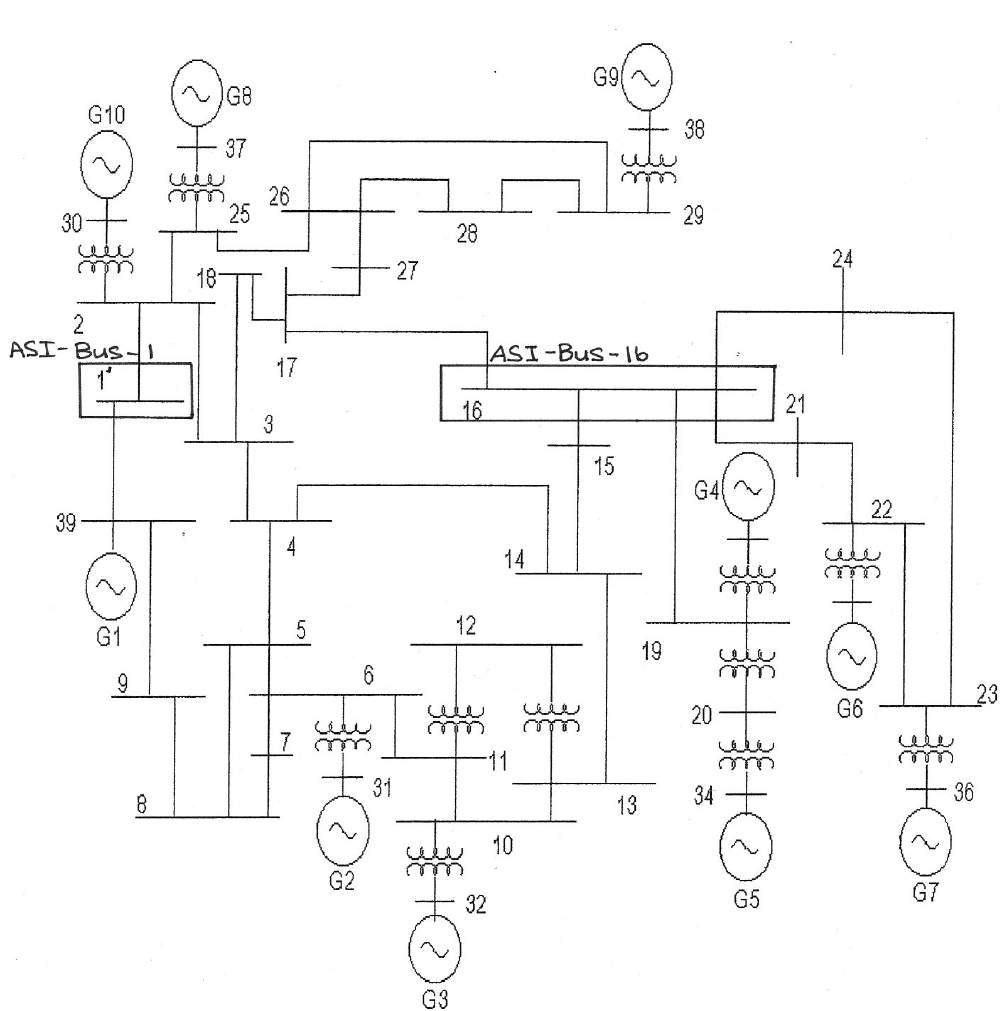
Figure 3. 10-machine, 39-Bus New England Test